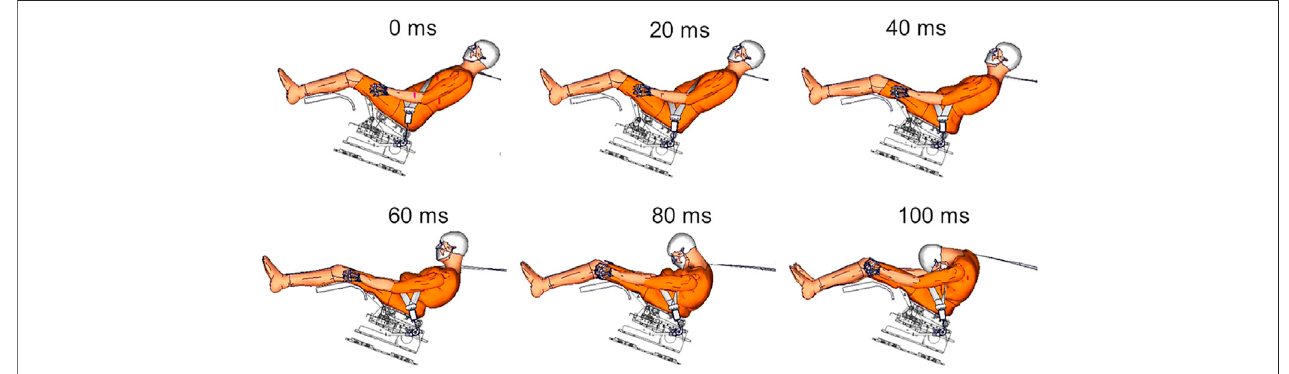
FIGURE 5 | Kinematic responses for mid-sized males in high-severity crash pulse in 20 ms increments, starting at 0 ms and ending at 100 ms.